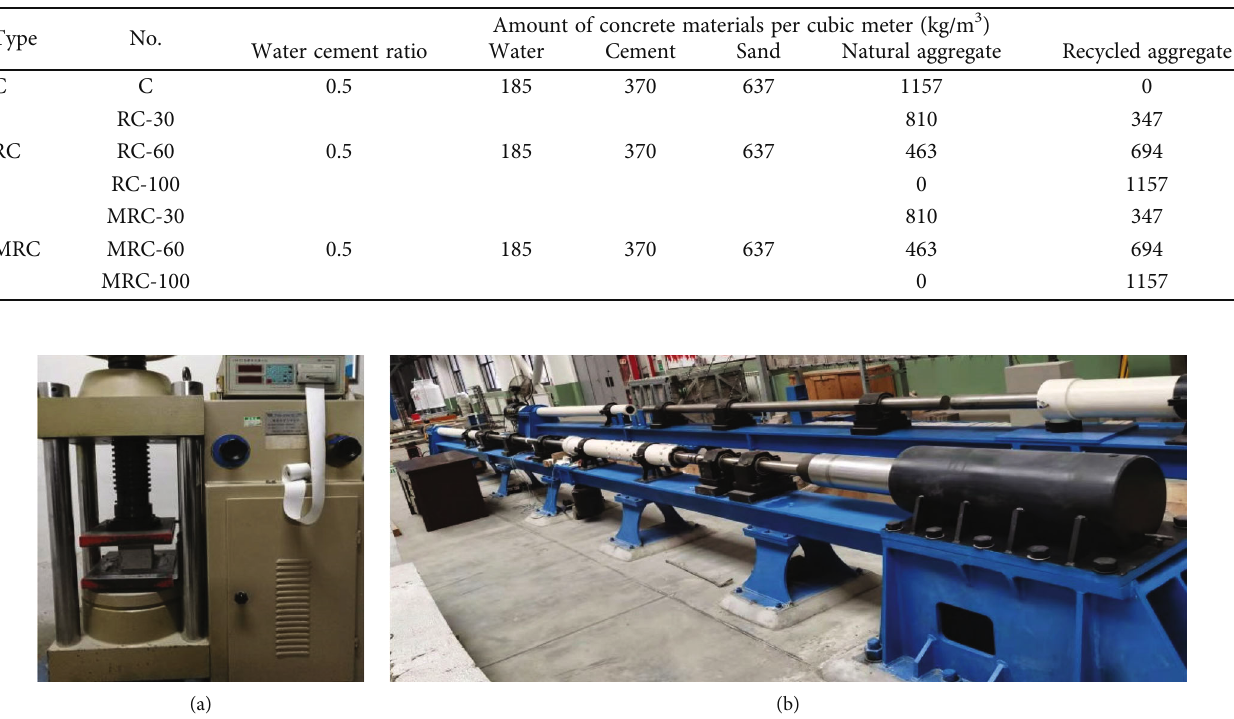
Table 1: 1 m 3 recycled concrete mixture.